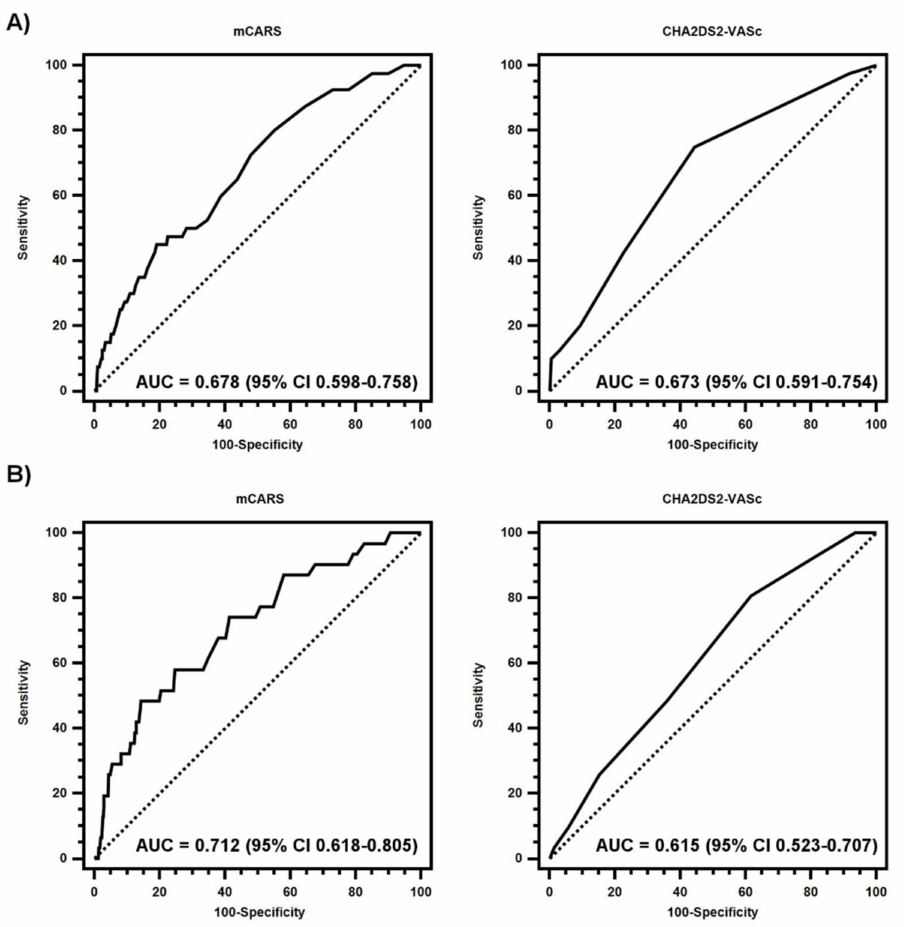
Figure 1. Receiver-operating characteristic curves for 1-year stroke events by mCARS and CHA 2 DS 2 - VASc score in the clinical trial ( A ) and real-world ( B )